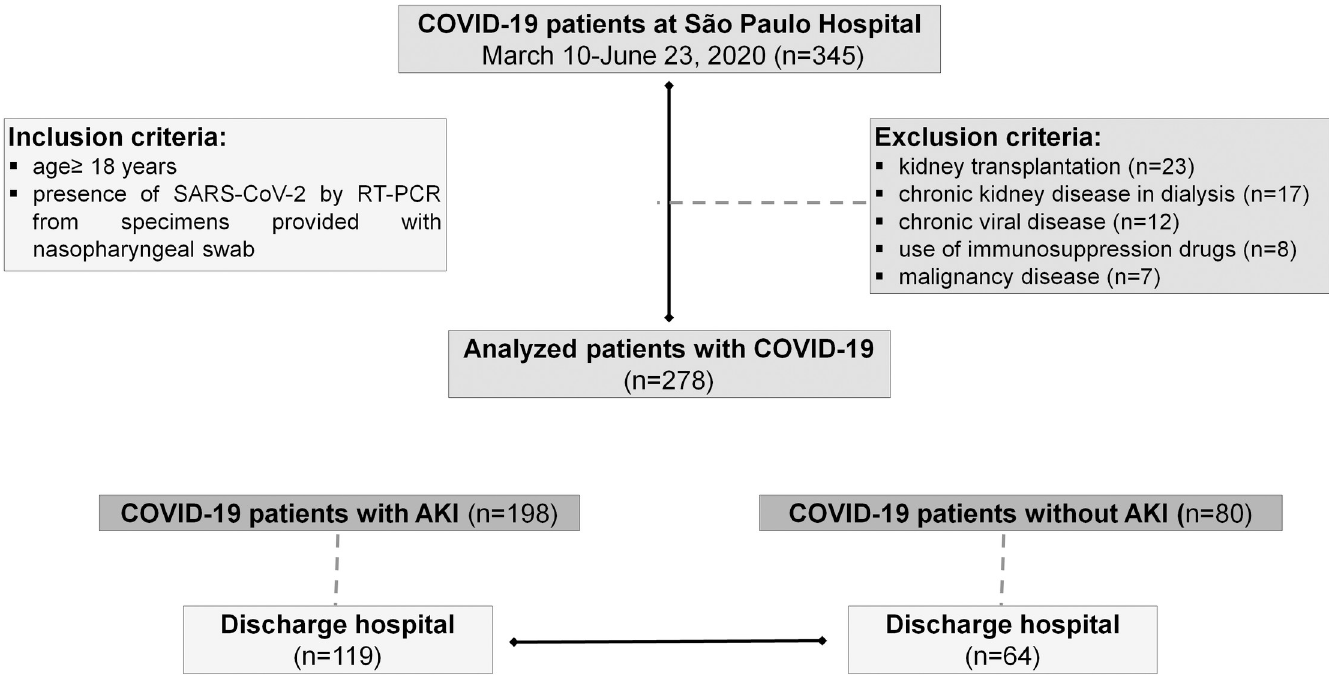
Fig 1. Workflow diagram of the patient selection. A total of 345 patients SARS-CoV-2 confirmed by RT-PCR from specimens provided with nasopharyngeal swab were selected from Hospital S ã o Paulo of Federal University of S ã o Paulo. After exclusion criteria, the remaining patients (n = 278) were subdivided into two subgroups: 1) COVID-19 patients with AKI (n = 198) and 2) COVID-19 patients without AKI (n = 80).